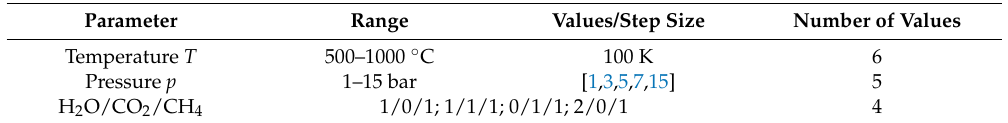
Table 3. Parameter combinations for validation.